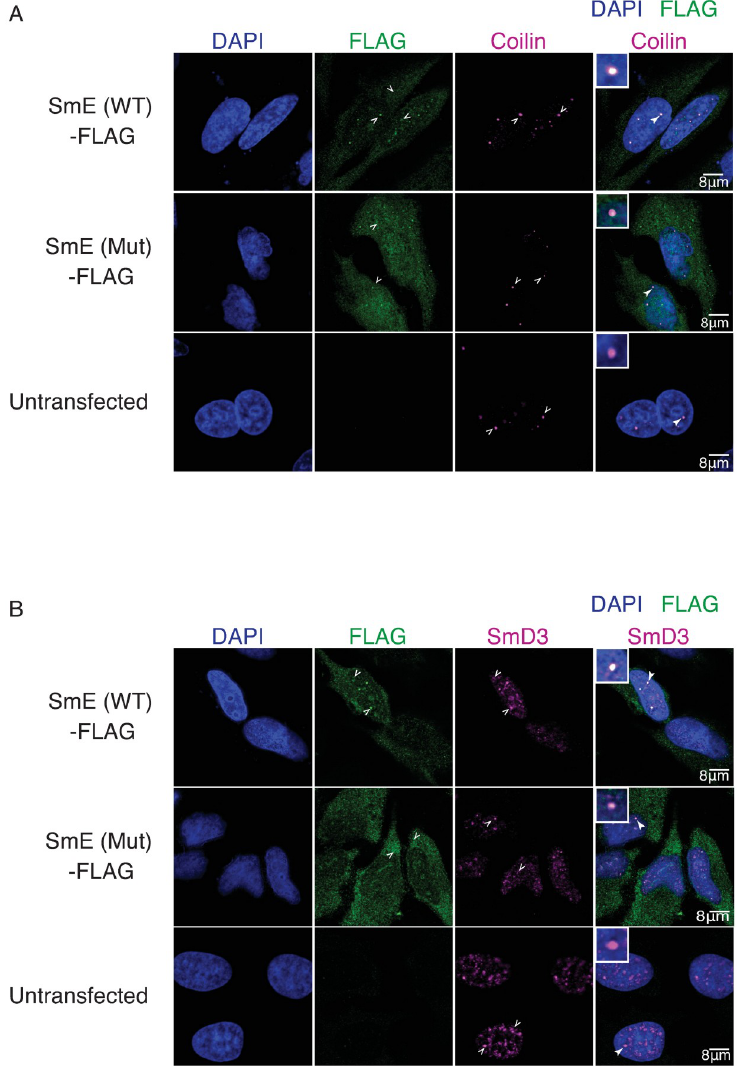
Fig 3. NSM mutation causes mis-localization of the SNRPE/SmE protein. (A-B), Indirect immunofluorescence and confocal microscopy of HeLa cells transfected with either FLAG-tagged wild type or mutant SmE (WT/Mut) or left untransfected (negative control). Empty white arrowheads indicate localization pattern observed and filled white arrowheads indicate zoomed in region shown in the overly inset. (A), Top panel shows clear co-localization of wild type SmE (green) and coilin (magenta) in CBs and middle panel shows most of the mutant SmE (green) distributed in the cytoplasm with a minor fraction in the nucleus and co-localizing with coilin (magenta) in CBs. (B), While wild type SmE (green, top panel) co-localizes with SmD3 (magenta) in CBs and splicing speckles, the mutant SmE (green, middle panel) is predominantly cytoplasmic with marginal co-localization with SmD3 in CBs or in nuclear speckles.